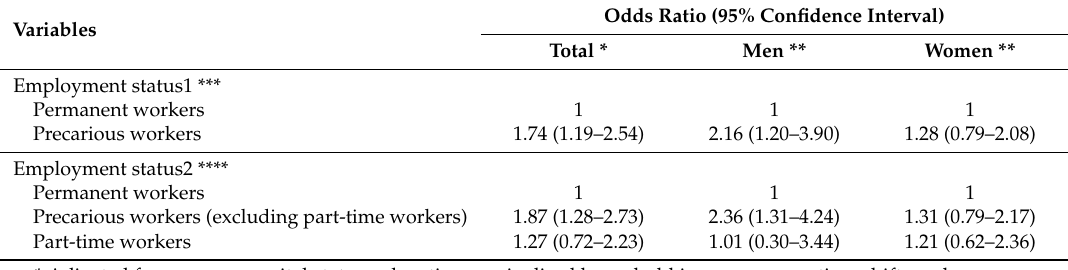
Table A1. Association between self-reported unmet healthcare needs and employment status by sex.